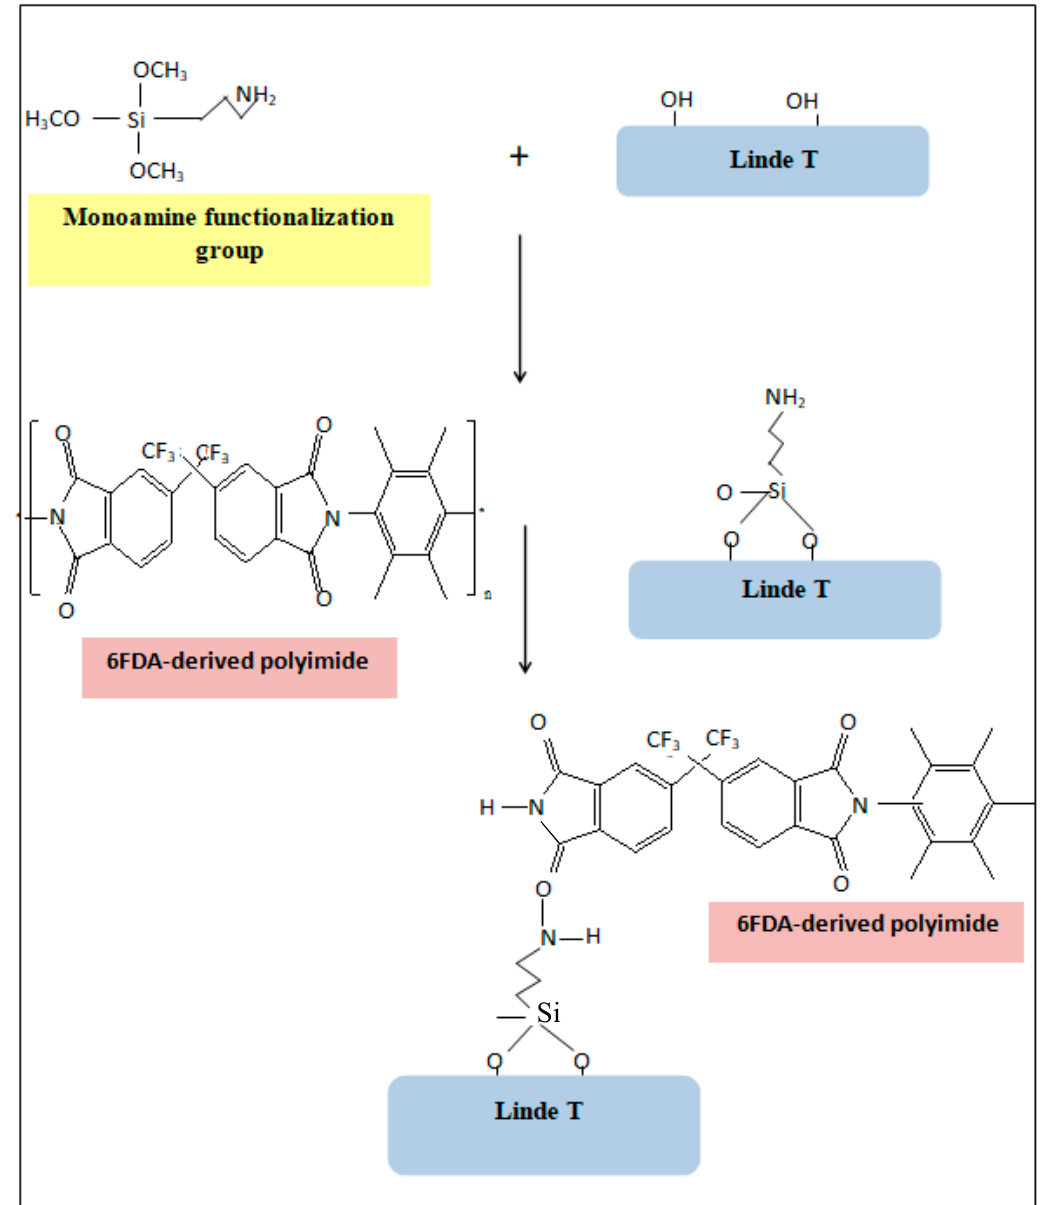
Figure 2. Amine functionalization agent reaction mechanism with 6FDA-derived polyimide and Linde T particles, adapted from Wahab et al. (2008) [43].